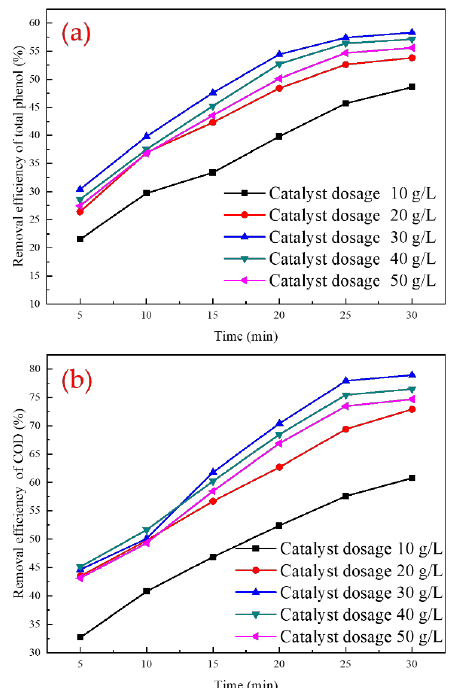
Figure 6. Effects of catalyst dosages on removal efficiency of ( a ) total phenol, ( b ) COD.